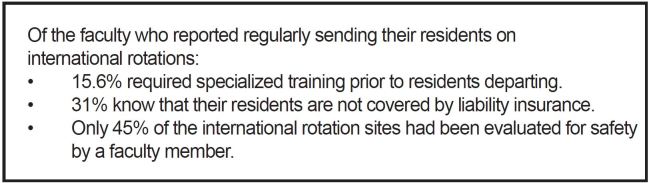
Summary of results.